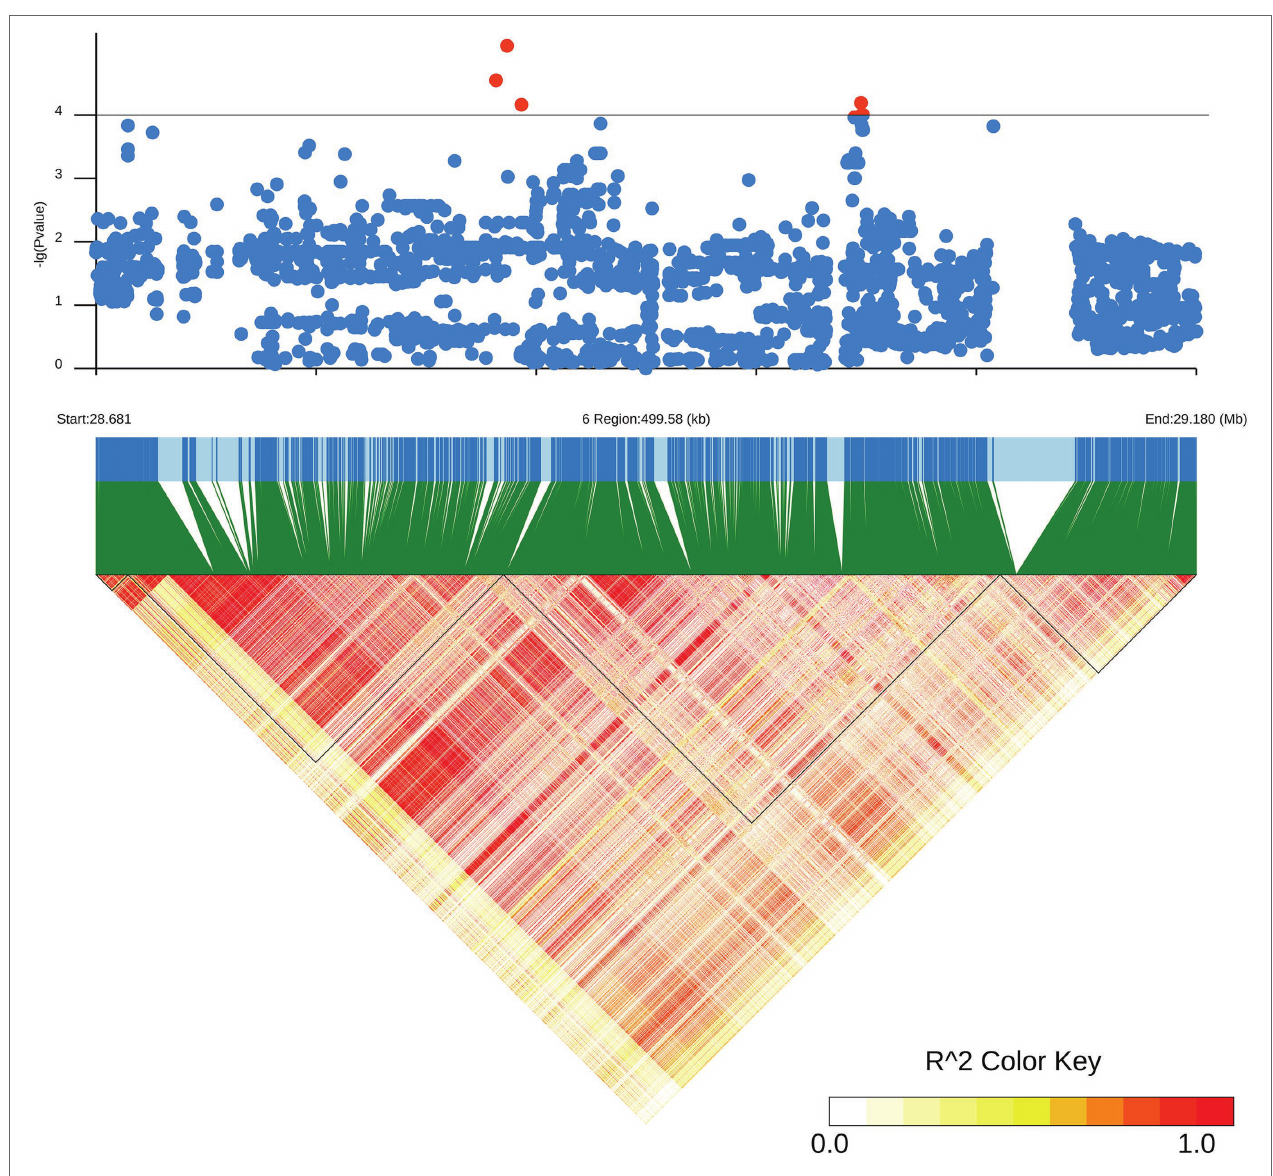
FIGURE 2 | Local Manhattan plot (upper) and LD heatmap (lower) surrounding the lead SNP for SKC on chromosome 6.